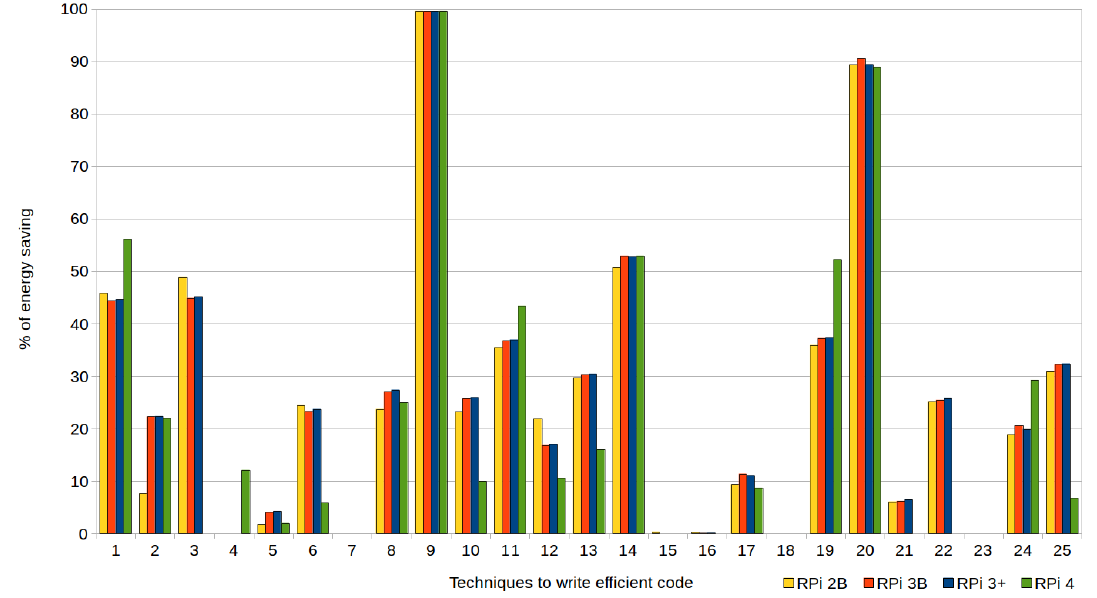
Figure 2. Percentages of energy saving achieved by writing energy-efficient code (without compiler